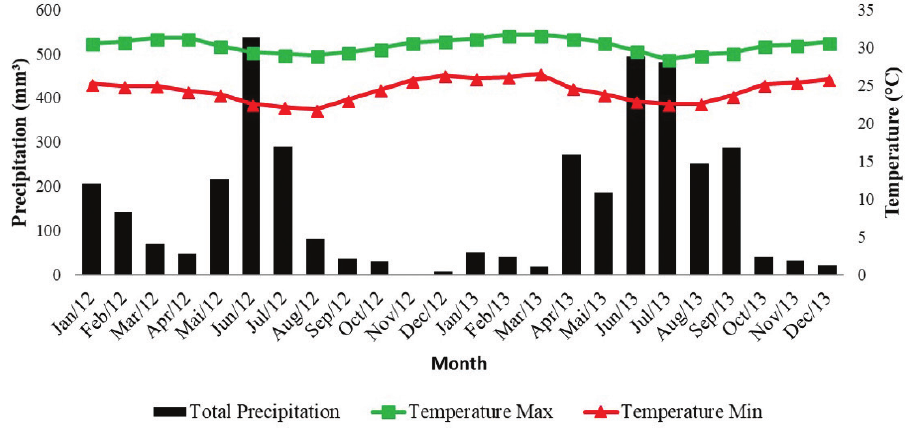
Figure 2. Variation of temperature, maximum (line with square) and minimum (line with triangle), pre- cipitation as bars. Data from January 2012 and December 2013 (Source: INMET, http://www.inmet. gov.br/portal/index.php?r=bdmep/bdmep